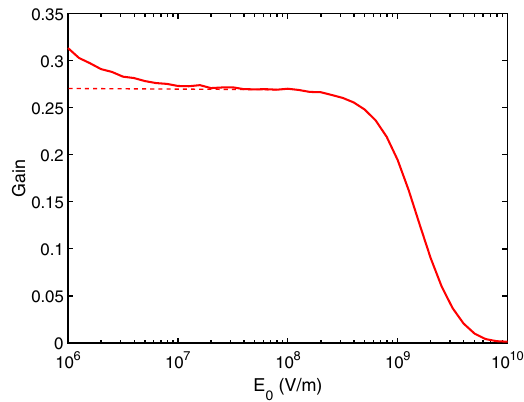
FIG. 3. The gain as a function of electric field intensity. (The dash line is the expected constant gain function curve in the low- gain theory at small electric